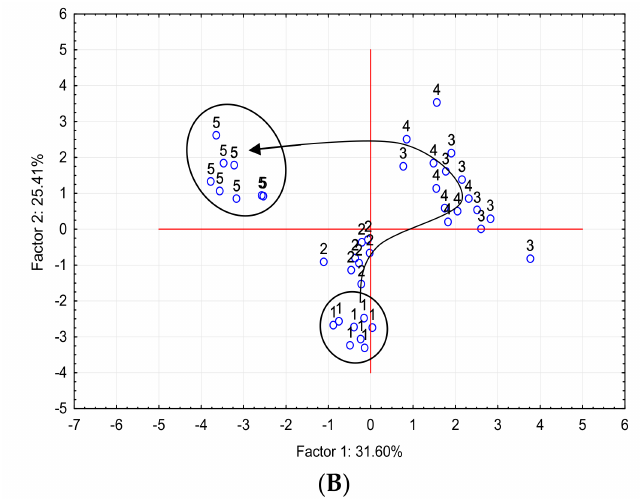
Figure 5. Principal component analysis (PCA) performed with copigmentation parameters in wines from different micro-oxygenation and wood strategies. 1, 2, 3, 4, and 5: samplings carried out in each tank after 20, 48, 76, 97, and 111 days’ aging, respectively.